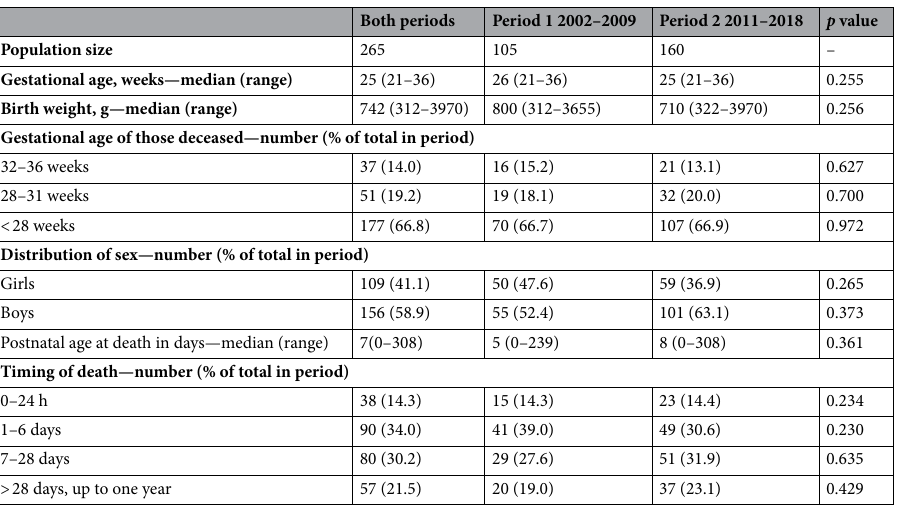
Table 1. Characteristics of deceased